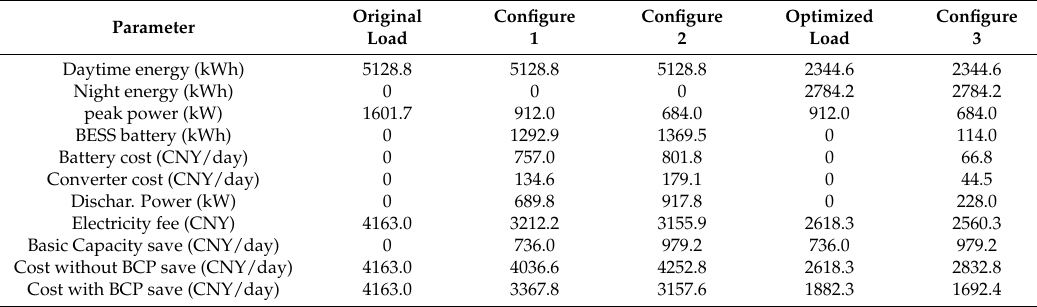
Table 11. Different charging modes’ costs with BESS from TOU